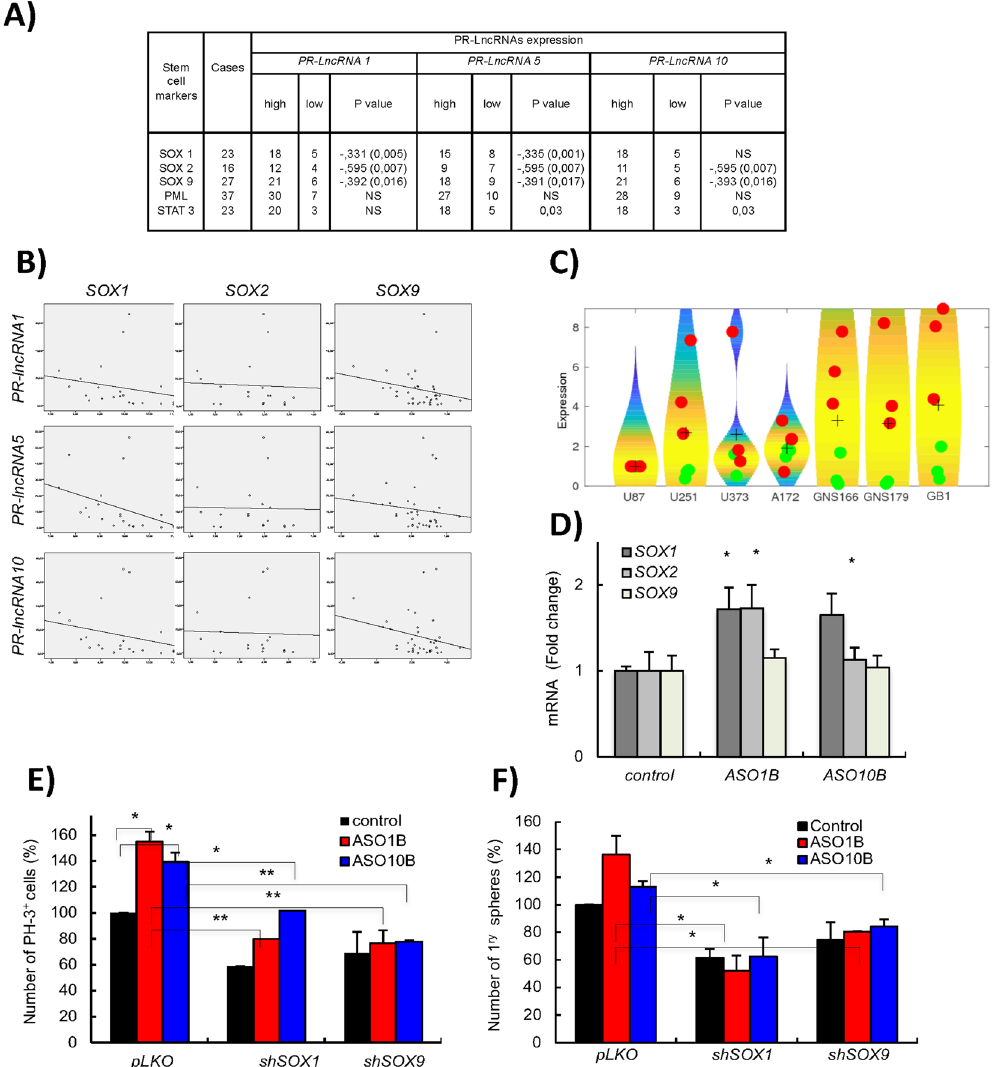
Figure 4. SOX stem cell factors mediate activity of PR-LncRNAs . ( A ) Analysis of the association between expression of PR-LncRNAs and stem cell factors in human glioma samples, showing there is a significant inverse correlation between PR-LncRNAs and SOX members. ( B ) Correlation between PR-LncRNAs and SOX factors in human glioma samples. Spearman Correlation Rho is − 0,546 ( ** ), − 0,221 and − 0,342 ( * ) for SOX1 , SOX2 and SOX9 with PR-LncRNA1 . It is − 0,670 ( *** ), − 0,151 and − 0,285 ( * ) for SOX1 , SOX2 and SOX9 with PR-LncRNA5 . Finally numbers are − 0,521 ( ** ), − 0,171 and − 0,230 for SOX1 , SOX2 and SOX9 with PR- LncRNA10 . ( C ) Violin plots associated to the expression distribution of the PR-LncRNAs (green circles) and SOX factors (red circles). Values in indicated cells are relative to expression of each transcript in U87-MG cells. The + denote the mean values of the distributions and the black dots are the expression values. ( D ) Quantitative reverse transcription polymerase chain reaction of SOX1 , SOX2 and SOX9 in U87-MG control and transfected with ASOs. Data represents the average of 3 independent experiments. ( E ) Quantification of the number of P-H3 positive cells in U87-MG cells transfected with indicated ASOs and lentivirally infected with shSOX1 , shSOX9 or empty vector ( pLKO ) (n = 2). ( F ) Quantification of the number of formed oncospheres in U87 cells transfected with indicated ASOs and lentivirally infected with shSOX1 , shSOX9 or empty vector ( pLKO ) (n = 2). P values were determined by Student’s t test. Asterisks ( * , ** ) indicate statistical significance (p < 0.05 and p <